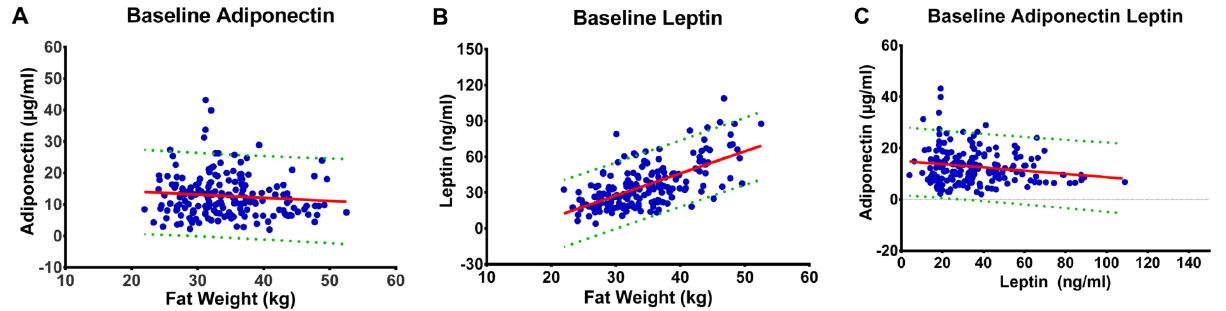
Figure 1. Regression Analyses of Baseline data: ( a ) Regression of plasma adiponectin on fat mass (kg) with 95% confidence intervals; r 2 = 0.008, p = 0.210. ( b ) Regression of plasma leptin on fat mass (kg) with 95% confidence intervals; r 2 = 0.41, p < 0.001. ( c ) Regression of plasma adiponectin on plasma leptin with 95% confidence intervals; r 2 = 0.025, p =